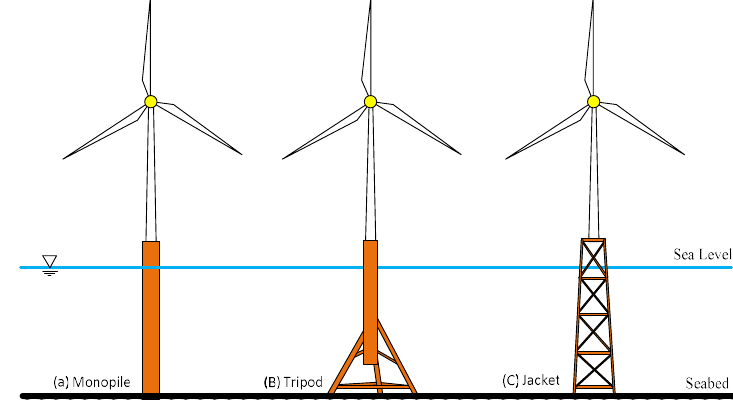
Figure 1. Different types of wind turbine offshore foundations. Figure 1. Di ff erent types of wind turbine o ff shore